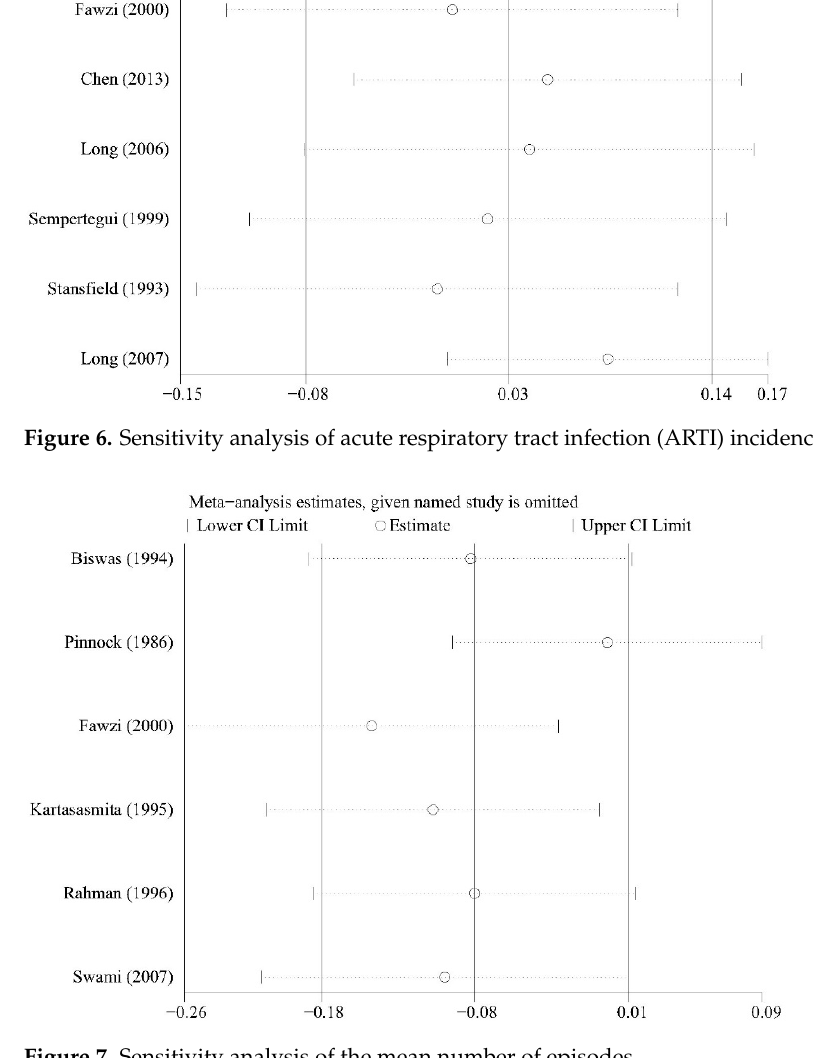
Figure 7. Sensitivity analysis of the mean number of episodes.